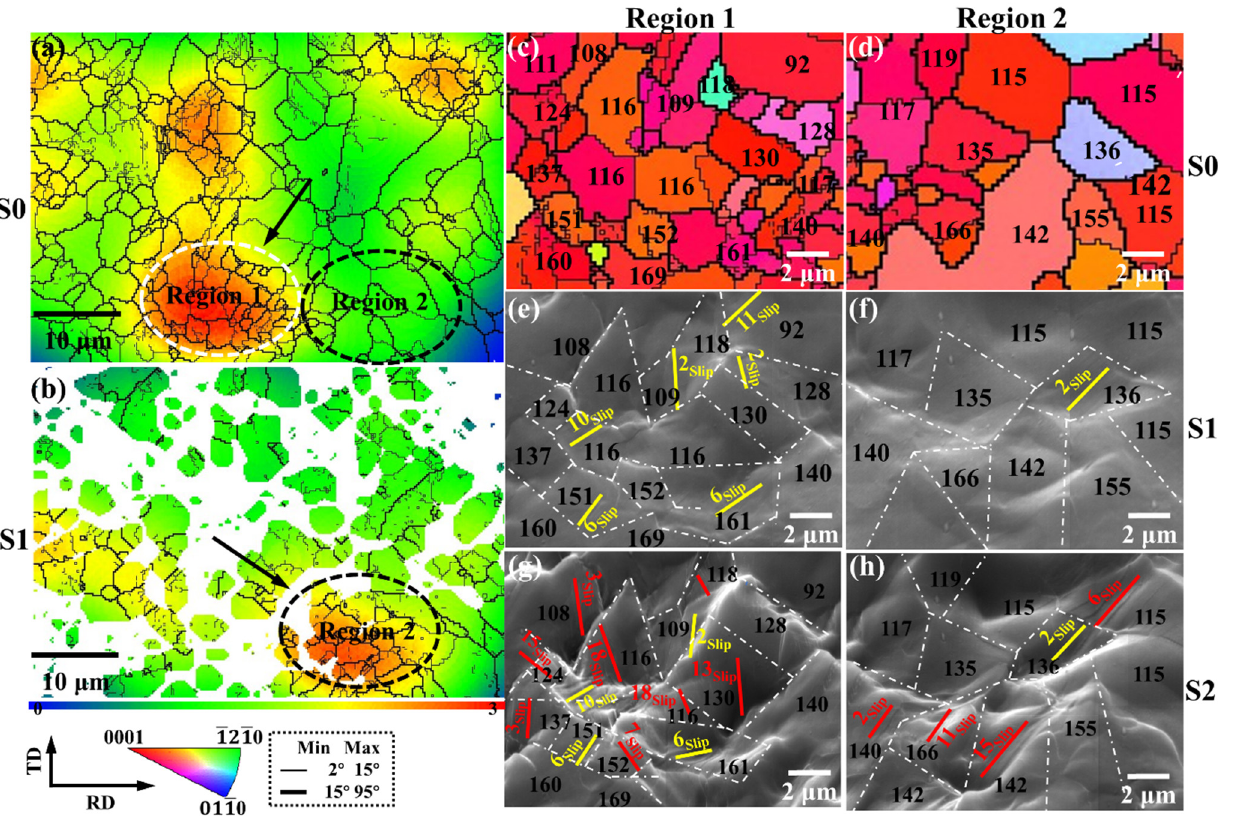
Figure 9. The plastic behavior of the small and large strain regions during uniaxial stretching: strain distribution of ( a ) S0 and ( b ) S1, ( c , d ) IPF images, and ( e – h ) SEM images at different strain stages. The slip system represented by the slip traces in the figure is shown in Figure 7. Figure 9a is the strain distribution of the microstructure before uniaxial stretching.